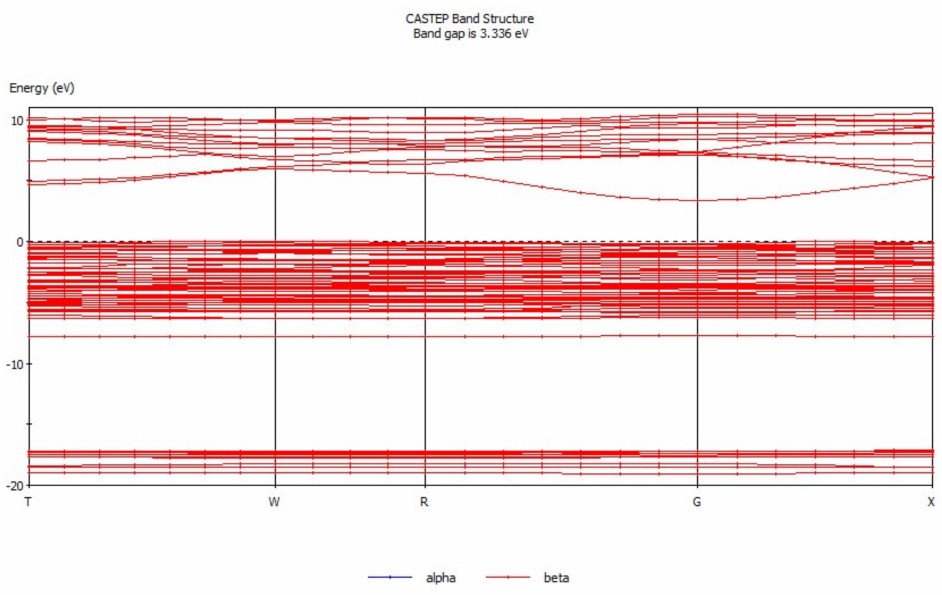
Figure 3. Energy band diagram of hemimorphite.